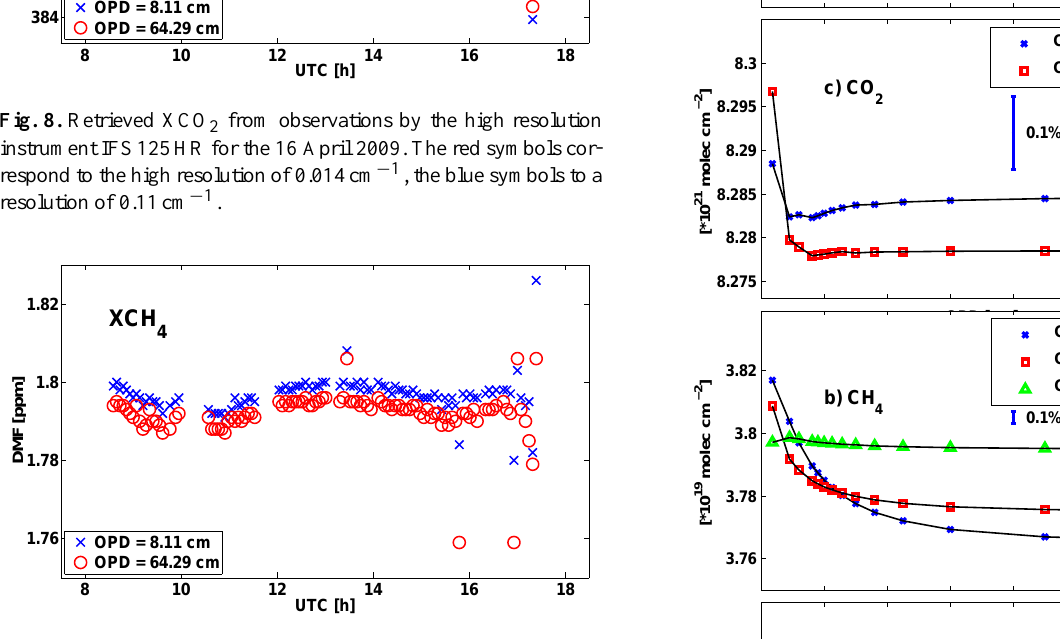
Fig. 9. Retrieved XCH 4 from observations by the high resolution instrument IFS125HR for the 16 April 2009. The red symbols cor- respond to the high resolution of 0.014cm − 1 , the blue symbols to a resolution of 0.11cm − 1 .